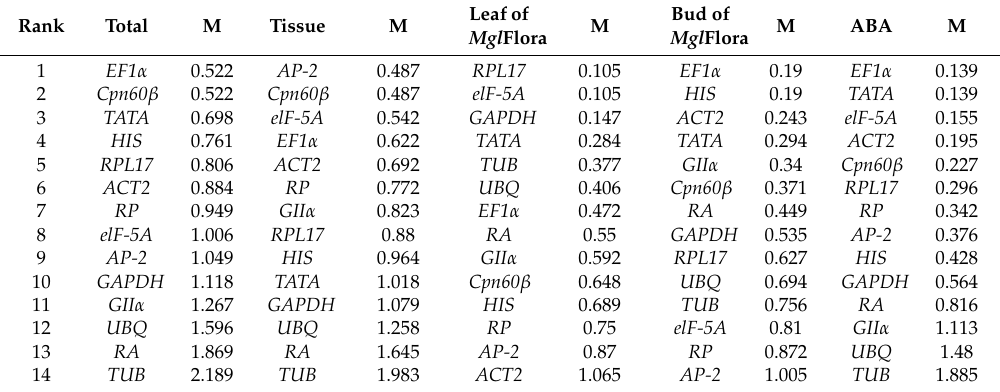
Table 4. Expression stability values of the 14 candidate reference genes calculated using